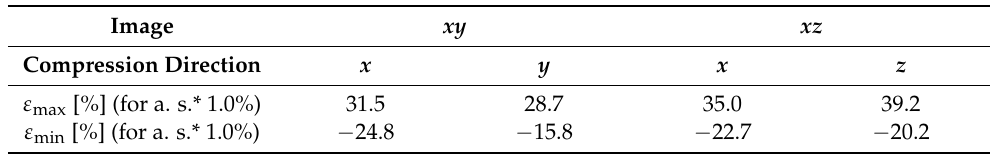
Figure 13. Contour graphs of the equivalent Mises stresses in ( a ) mortar and ( b ) aggregate. Table 7. Maximum and minimal principal strains depend on the particular image and the compression direction.